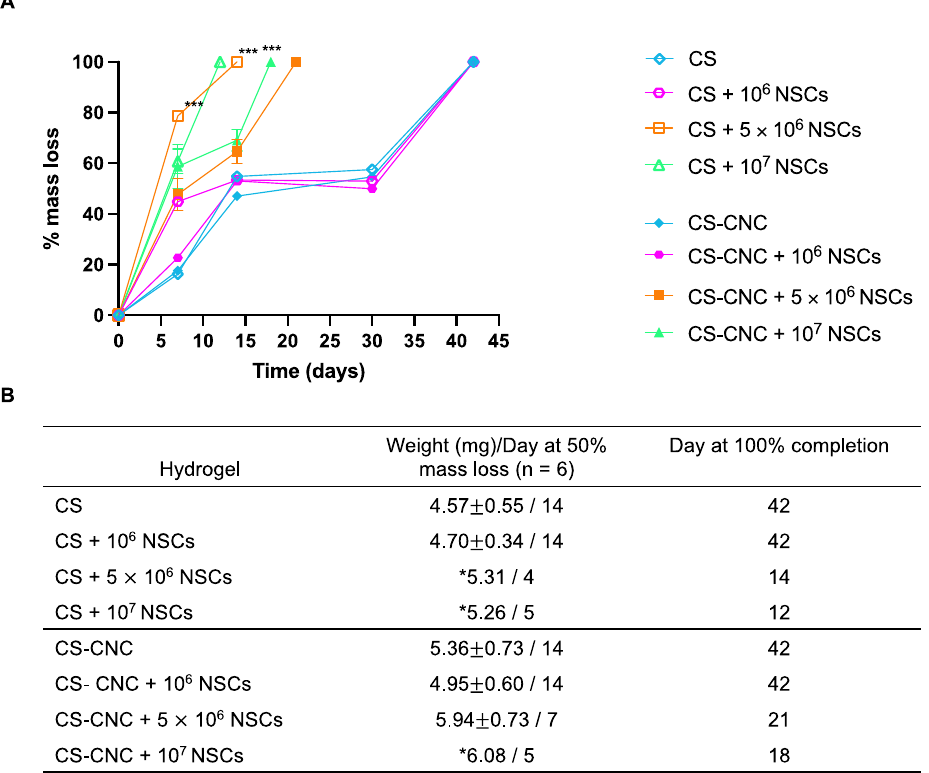
Figure 5. Effect of NSCs on hydrogel degradation over time. ( A ) Percent mass loss of CS-CNC hydrogels with and without NSCs ( n = 6, 200 μ L samples; *** indicates p < 0.0001). ( B ) Summary table of mass at 50% degradation, time to 50% mass loss (days), and time to 100% completion (days) (mass represented as mean ± standard deviation (SD); * indicates weight obtained from extrapolated hydrogel mass at 50% mass loss).